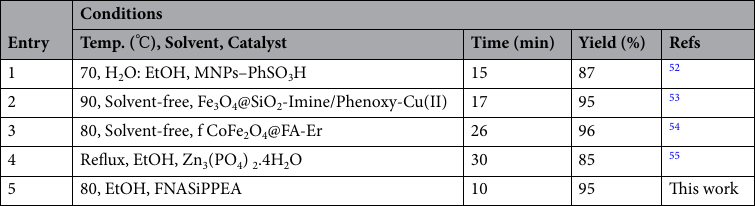
Table 6. Comparison of FNASiPPEA with other catalysts for the synthesis of DHPC.